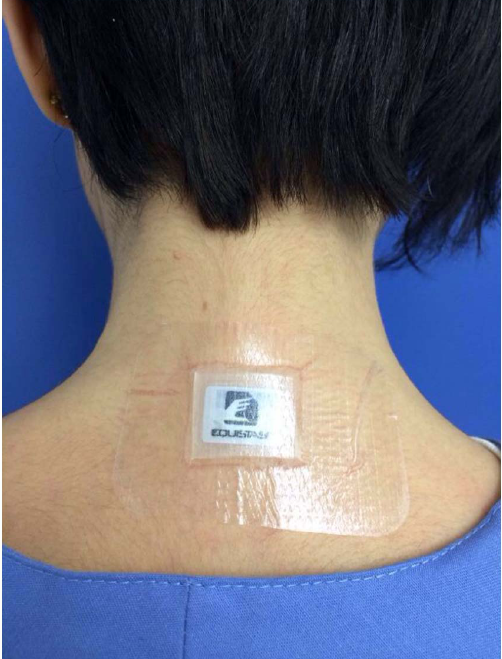
Figure 1. The wearable postural stabilizer (Equistasi) employed in the present